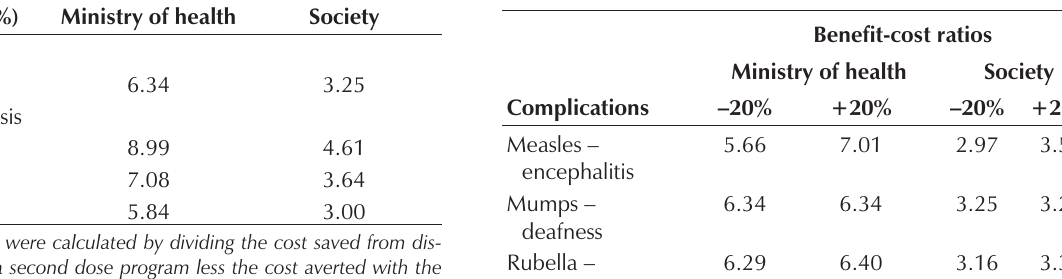
Benefit-cost ratios and sensitivity analysis Benefit-cost ratios*